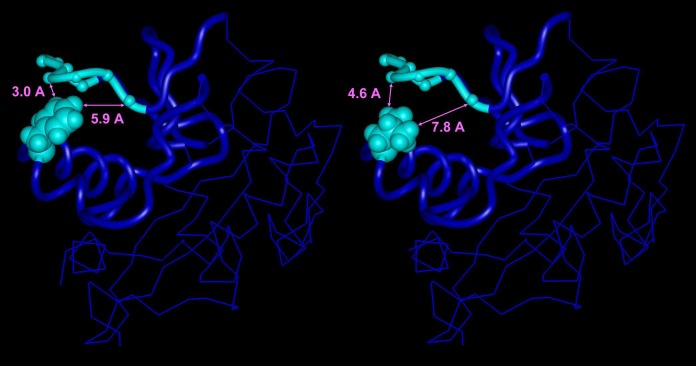
Comparison of the “Open” Configuration of F96 and L96 Variants of the TRA-3 DIIa DomainThe region between 61–114 and 149–161, containing the calcium-binding site, and the sequence stretch around position 96 is represented as a solid oval ribbon while the rest is in trace representation. Position 96 and the flexible calcium loop 66–73 with alpha carbons are shown as balls are in light blue. The side chains of N2 F96 (left) and its CB mutant L96 (right) are in space-filling representation. Mutation F96L introduces a void of ~1.5 Å that the loop containing the calcium-binding site can sample during its dynamics. As the number of configurations increases, this might reduce the ability for calcium binding. Distances shown in the figure are between the closest atom of the lateral chain of the F/L96 and the alpha carbons of F66 and G69 respectively.